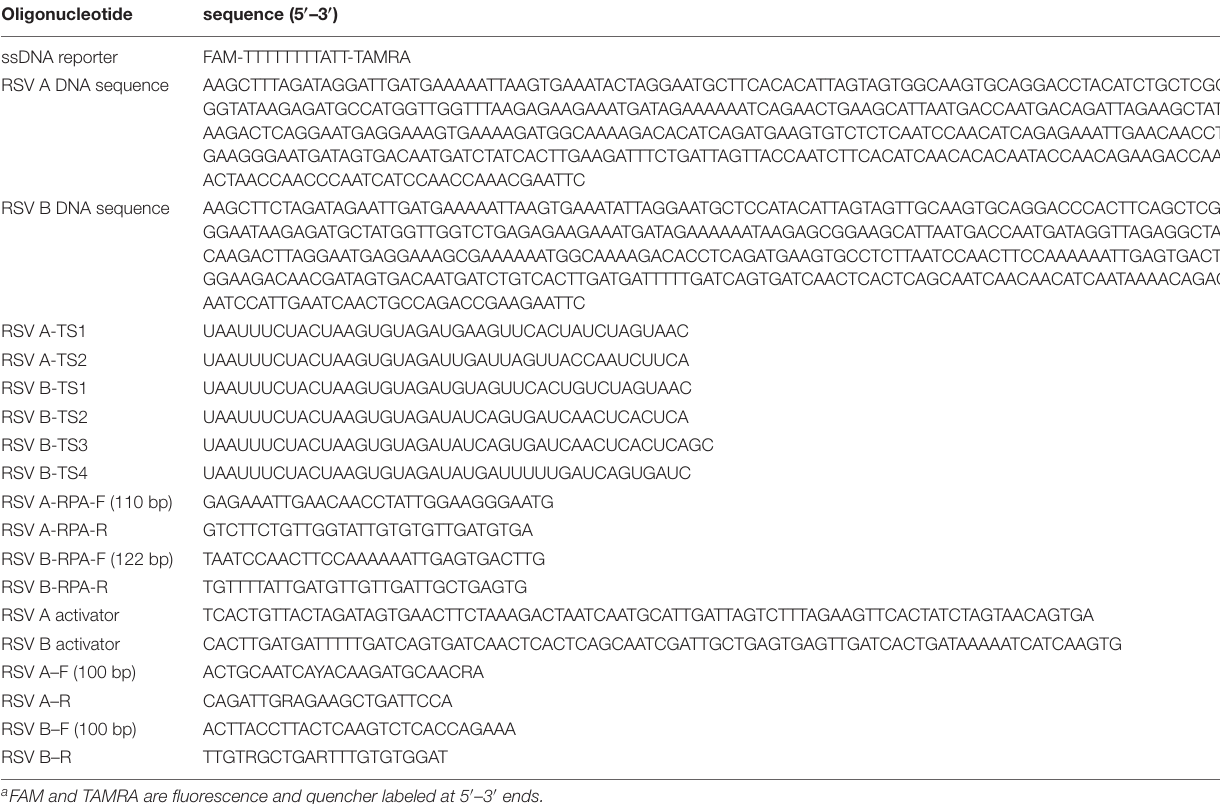
TABLE 1 | Oligonucleotide sequences used in this study a − f . Oligonucleotide sequence (5 (cid:48) –3 (cid:48)